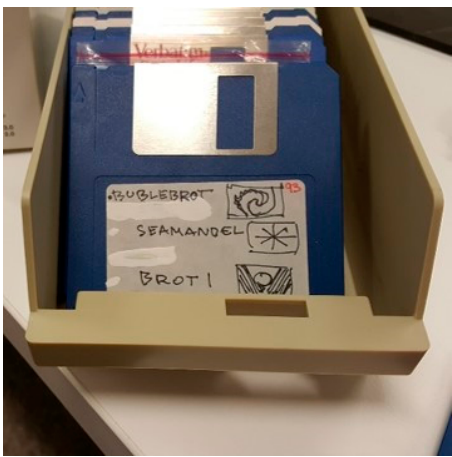
Figure 31. One of Ostoja’s floppy disks, showing his descriptive use of line drawings to label disks, and use of white-out on disk labels. SLSA disks taken in Flinders Computer Archaeology Lab. Image courtesy Melanie Swalwell. Published with permission of SLSA.